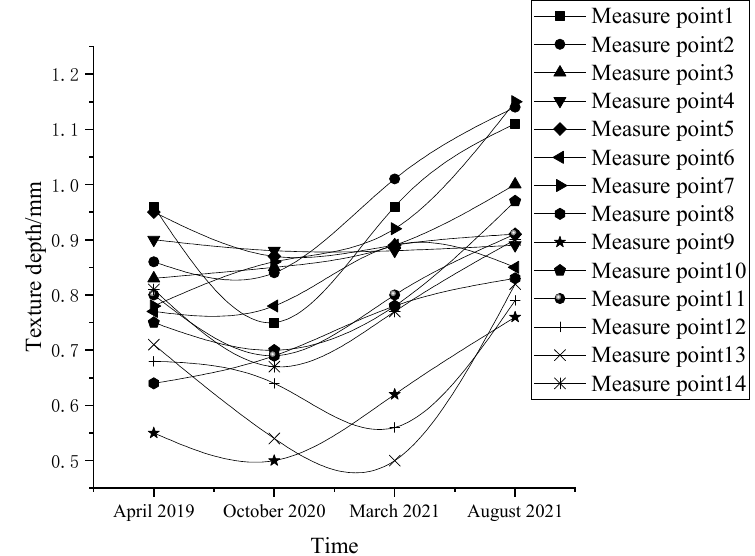
Figure 16. Results of the 3D construction depth inspection.